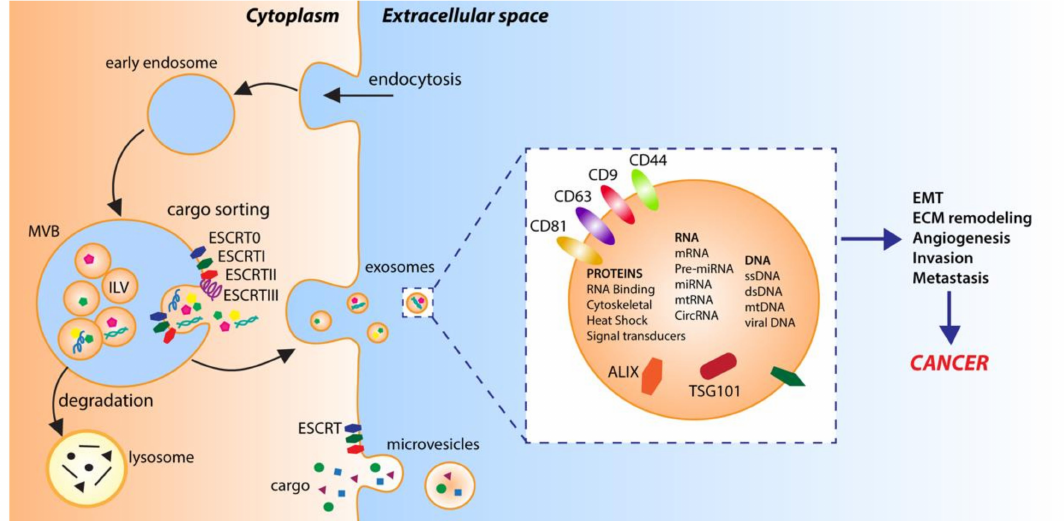
Figure 1. Extracellular vesicle biogenesis. Microvesicles are generated by direct outward budding from the plasma membrane. Exosomes are derived from intraluminal vesicles (ILV) generated by inward budding of the limiting membrane of early endosomes and multivesicular bodies (MVB). Endosomal sorting complexes required for transport (ESCRT0-III) and RNA-binding proteins are involved in sorting cargo into